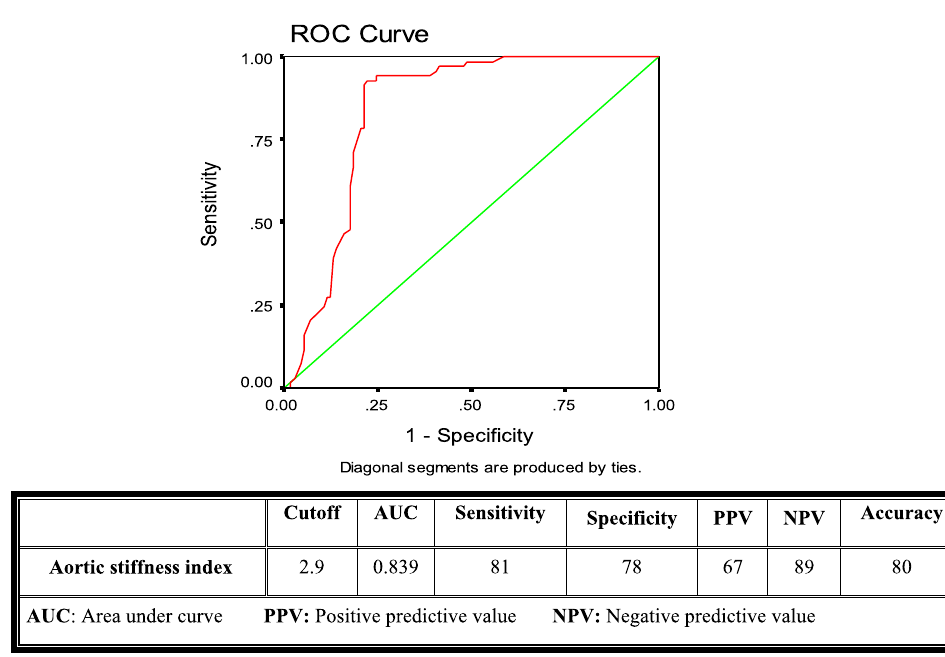
Fig. 3 The receiving operator characteristics curve for aortic stiffness index